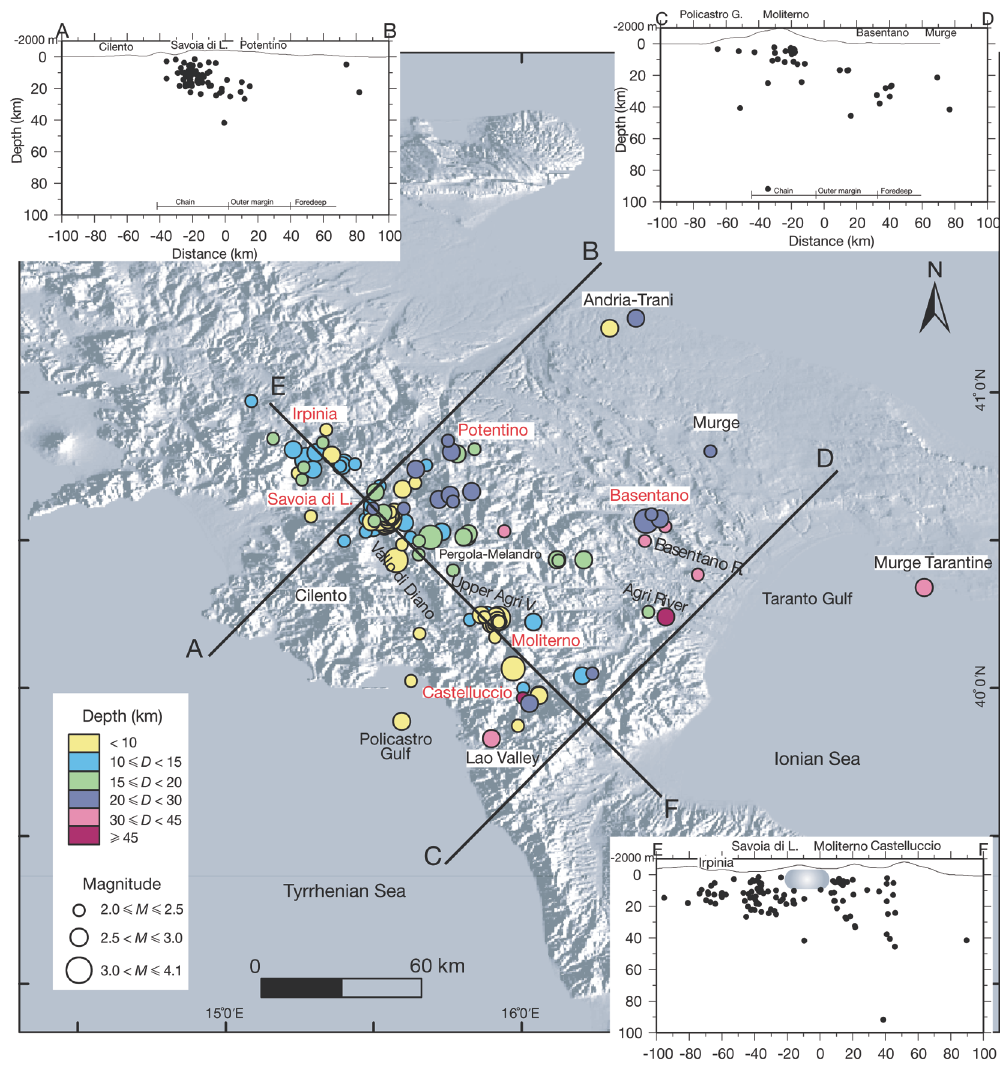
Fig. 4. Epicentral locations, depths and magnitudes of the local seismicity (120 earthquakes) selected for this study in the Lucanian Region. The three cross-sections in the insets show the projection of the hypocenters (see locations in the map). The maximum earthquake distance from sections AB, CD and EF is 30 km, 50 km and 200 km, respectively. Topography is vertically